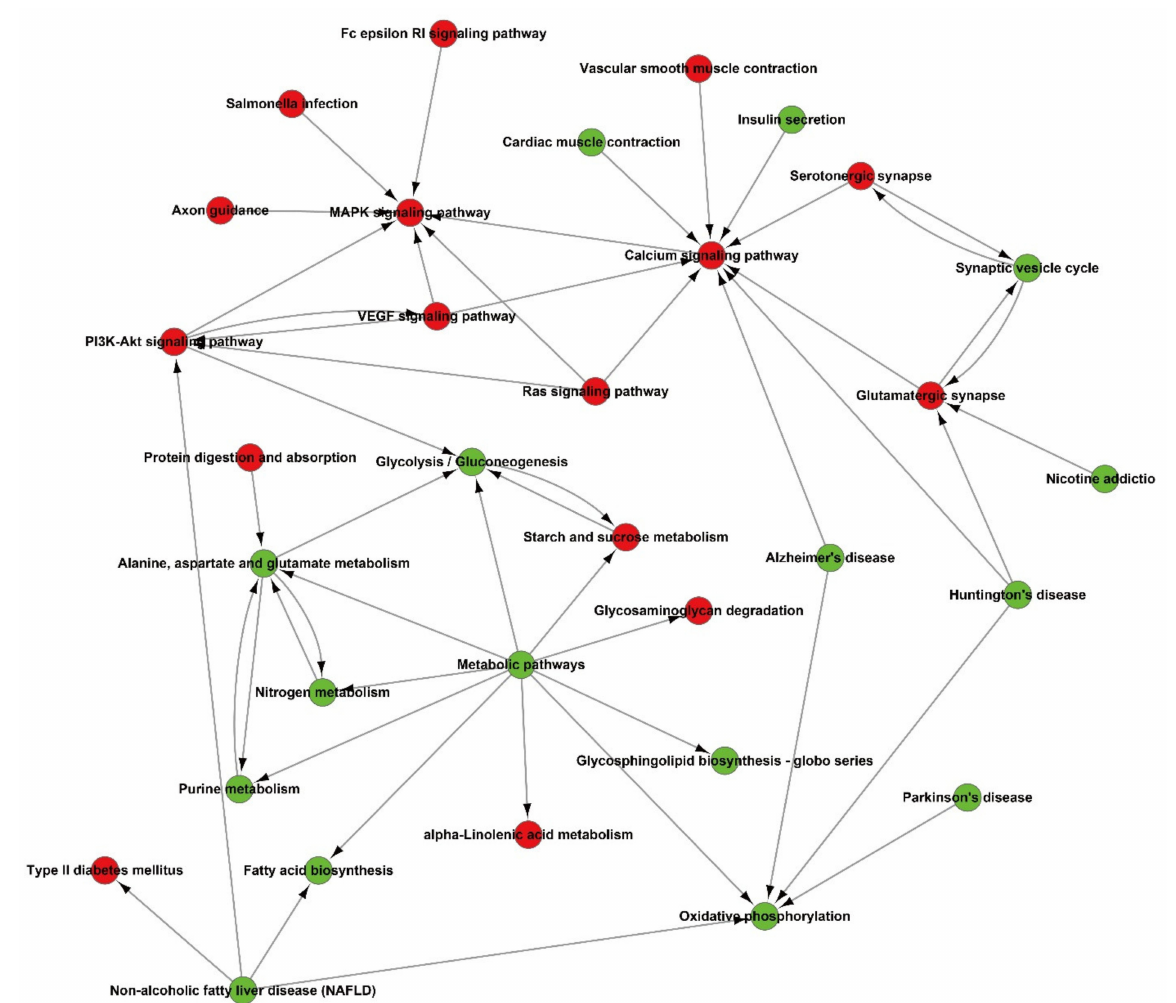
Figure 4. Interact network analysis for differentially expressed genes and